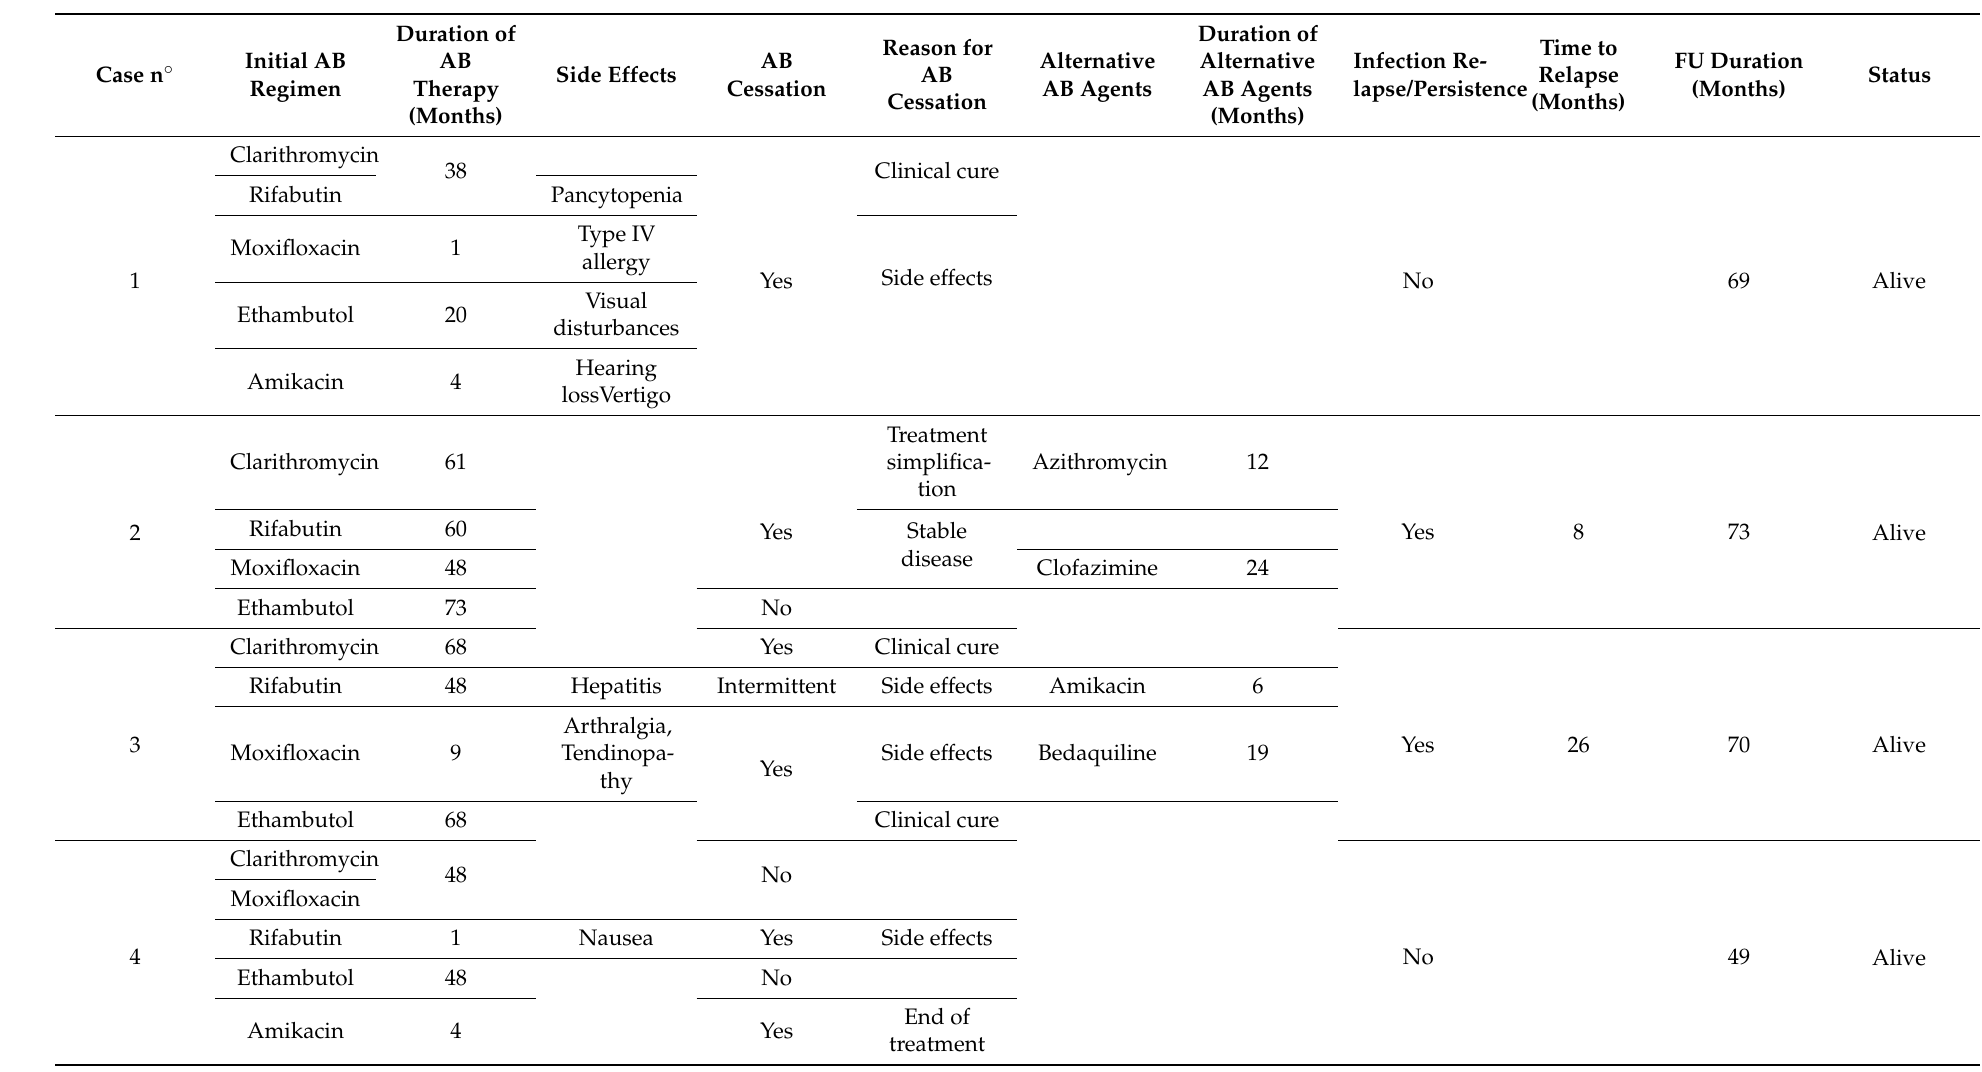
Table 4. Antimicrobial therapy management and infection